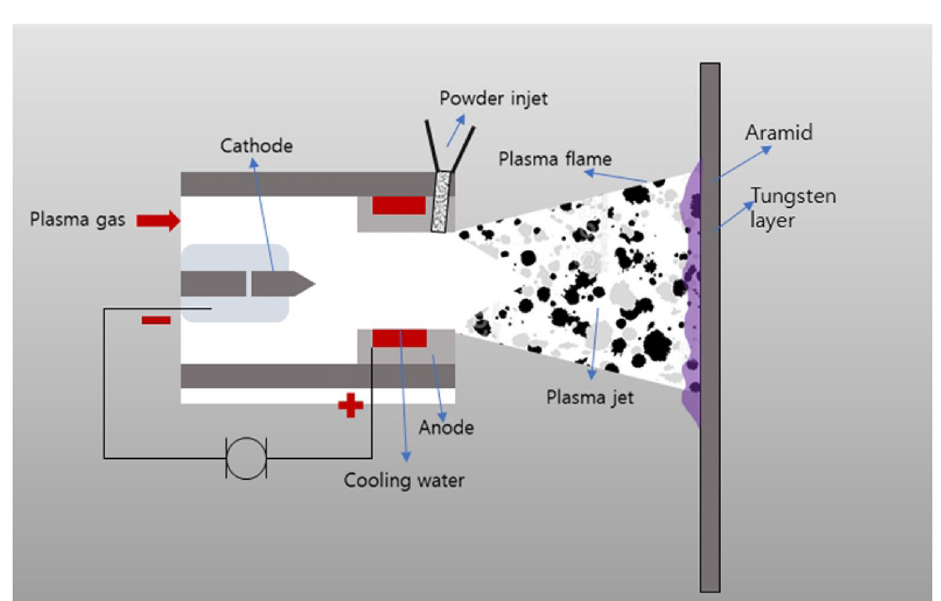
Figure 4. Schematic of plasma thermal spraying method.